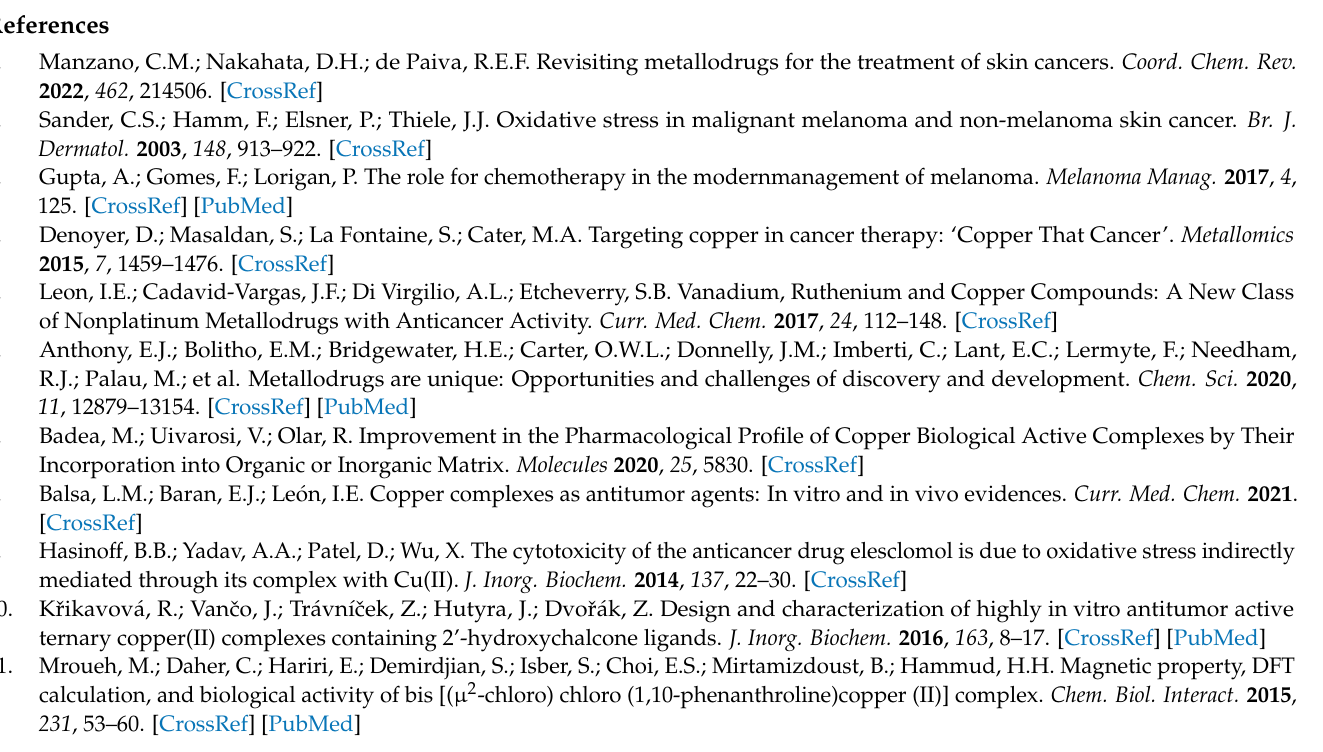
Figure S2: TG/DSC–MS graphs of all complexes from 25 to 600 ◦ C in air atmosphere: (a) complex (1), (b) complex (2), (c) complex (3), and, (d) complex (4). Table S1: IR bands (cm − 1) together with corresponding assignments; Table S2: Thermal data for complexes in air atmosphere. Representative mass peaks appear on Figure